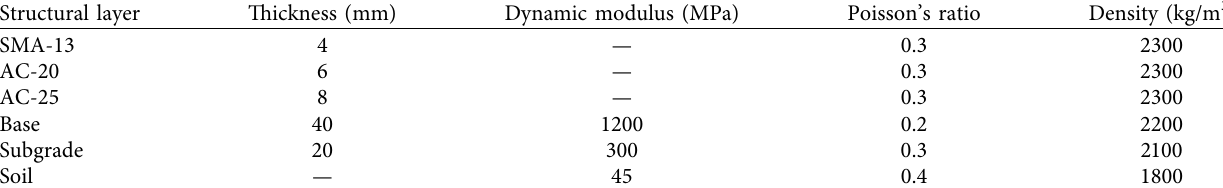
Table 4: Asphalt pavement structure and parameters